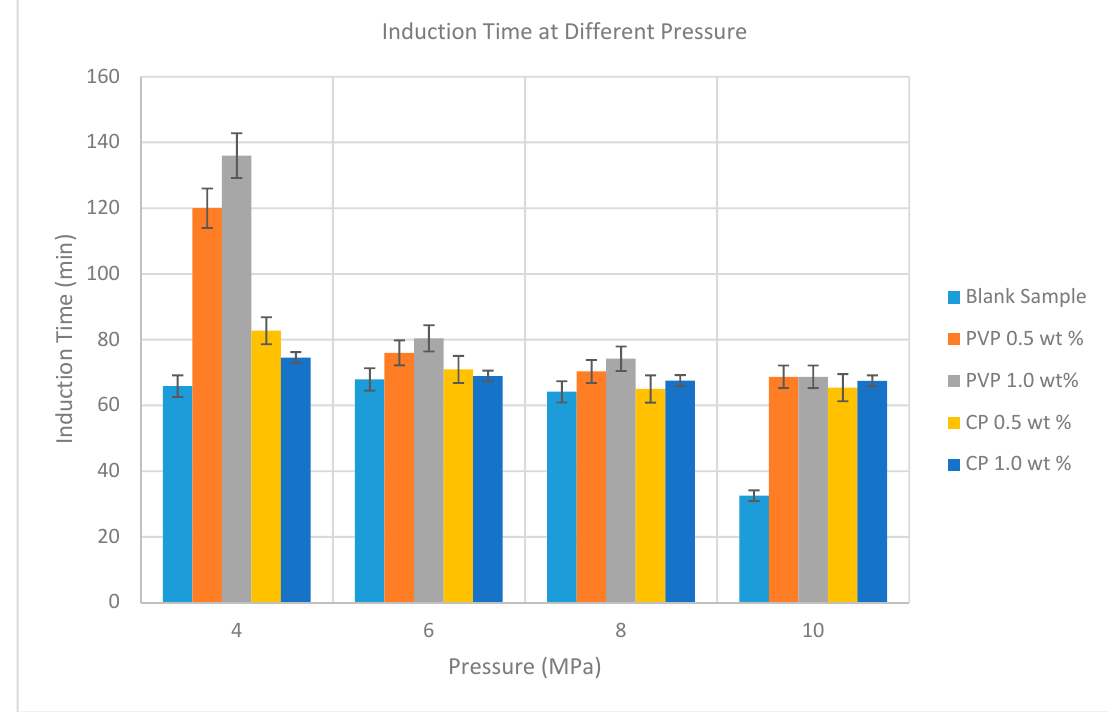
Figure 7. Induction time at different pressure.